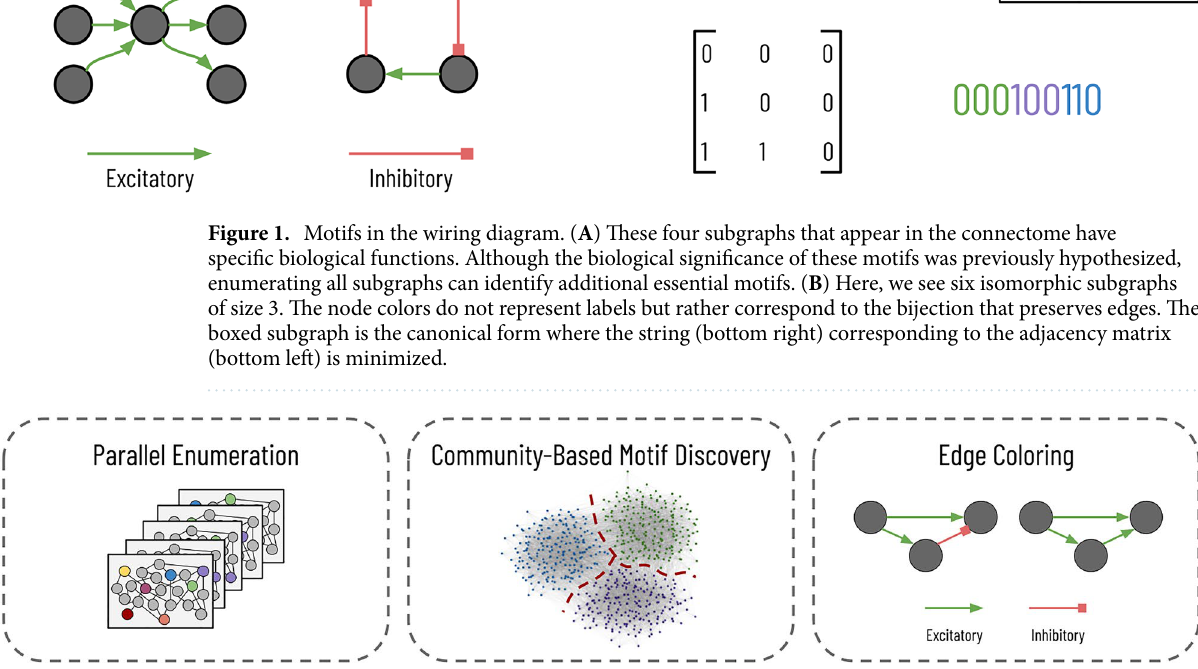
Figure 2. Subgraph enumeration for large-scale connectomes. We propose three improvements on existing subgraph enumeration strategies to improve throughput and better capture the underlying biology. First, we parallelize an existing subgraph enumeration strategy to work on a distributed cluster. For each job, we enumerate a subset of vertices, indicated here by color. Second, we first cluster the vertices into different communities for larger connectomes and perform subgraph enumeration within each community. Lastly, we add edge colors to the graph to match the diversity of the synaptic